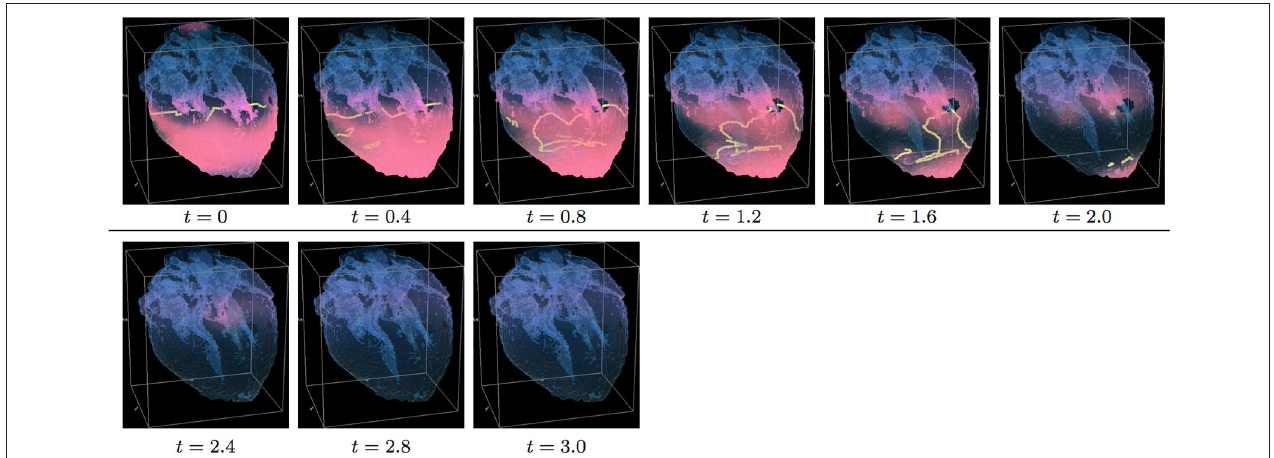
FIGURE 10 | Anisotropic “edited” whole heart simulation. The translucent fetal heart is shown in blue, excitation front shown in red (see the color box in Figure 3 ), the yellow lines are the instant organizing filaments of the excitation vortices; time shown under each panel in time units of Equations (1, 2). The anisotropy of the heart causes the fast significant transient distortion of the organizing filament of the initial excitation vortex, followed by the fast drift toward the apex and ultimate termination before the first rotation has ever started (See Supplementary Video 10